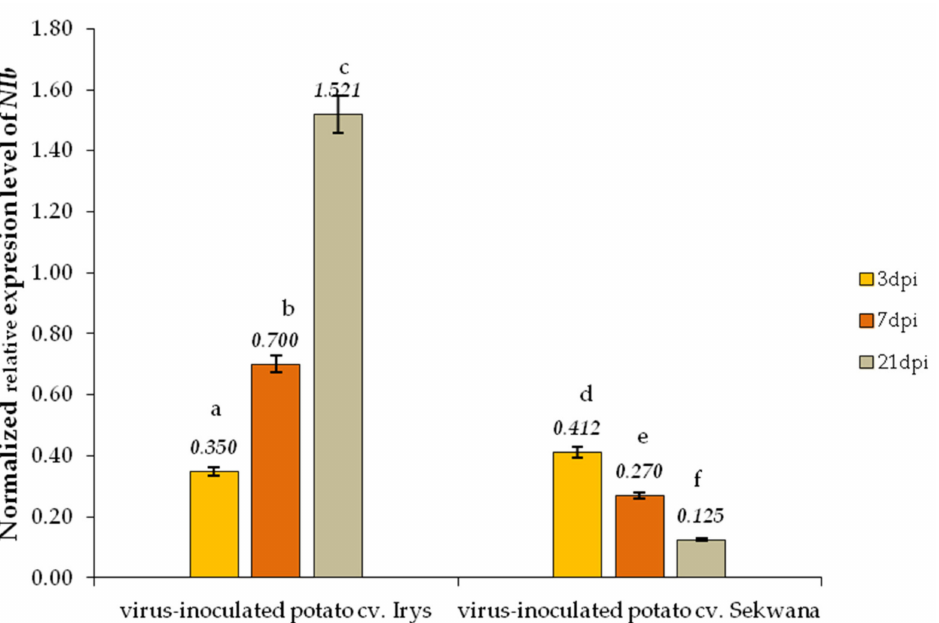
Figure 2. The normalized relative expression levels of PVY NTN - NIb were calculated based on the reference gene StEf1 α in mock- and virus-inoculated Irys and Sekwana cultivars between 3 and 21 dpi. By using ANOVA and Tukey’s HSD test, the mean values of normalized expression levels were calculated at p < 0.05. The statistically significant values are given in numbers above the bars.